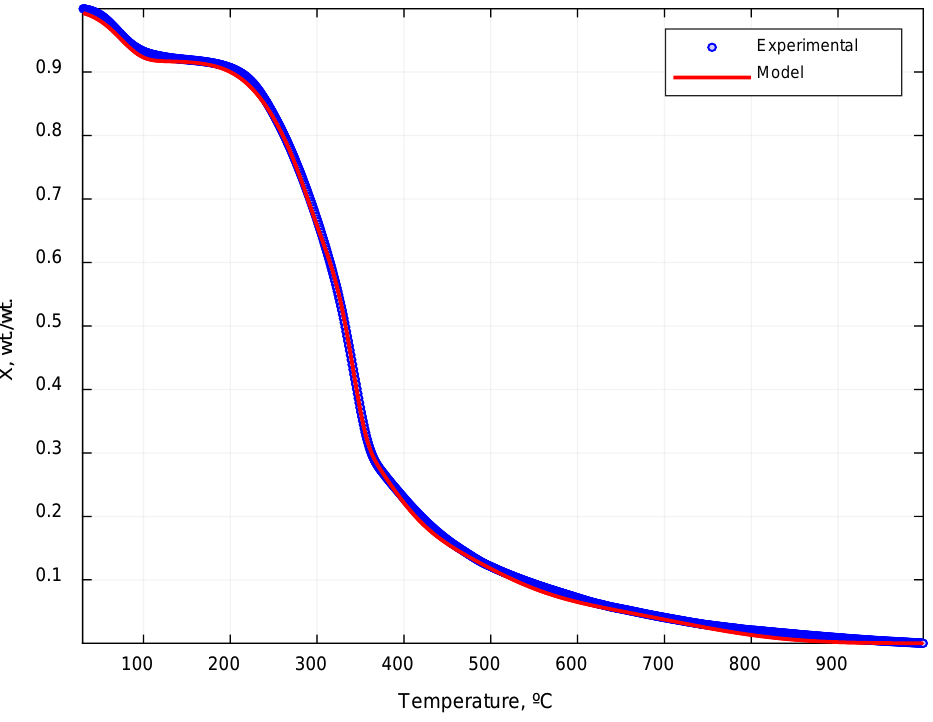
Figure 8. Model fitted to the experimental pine bark TG curve.